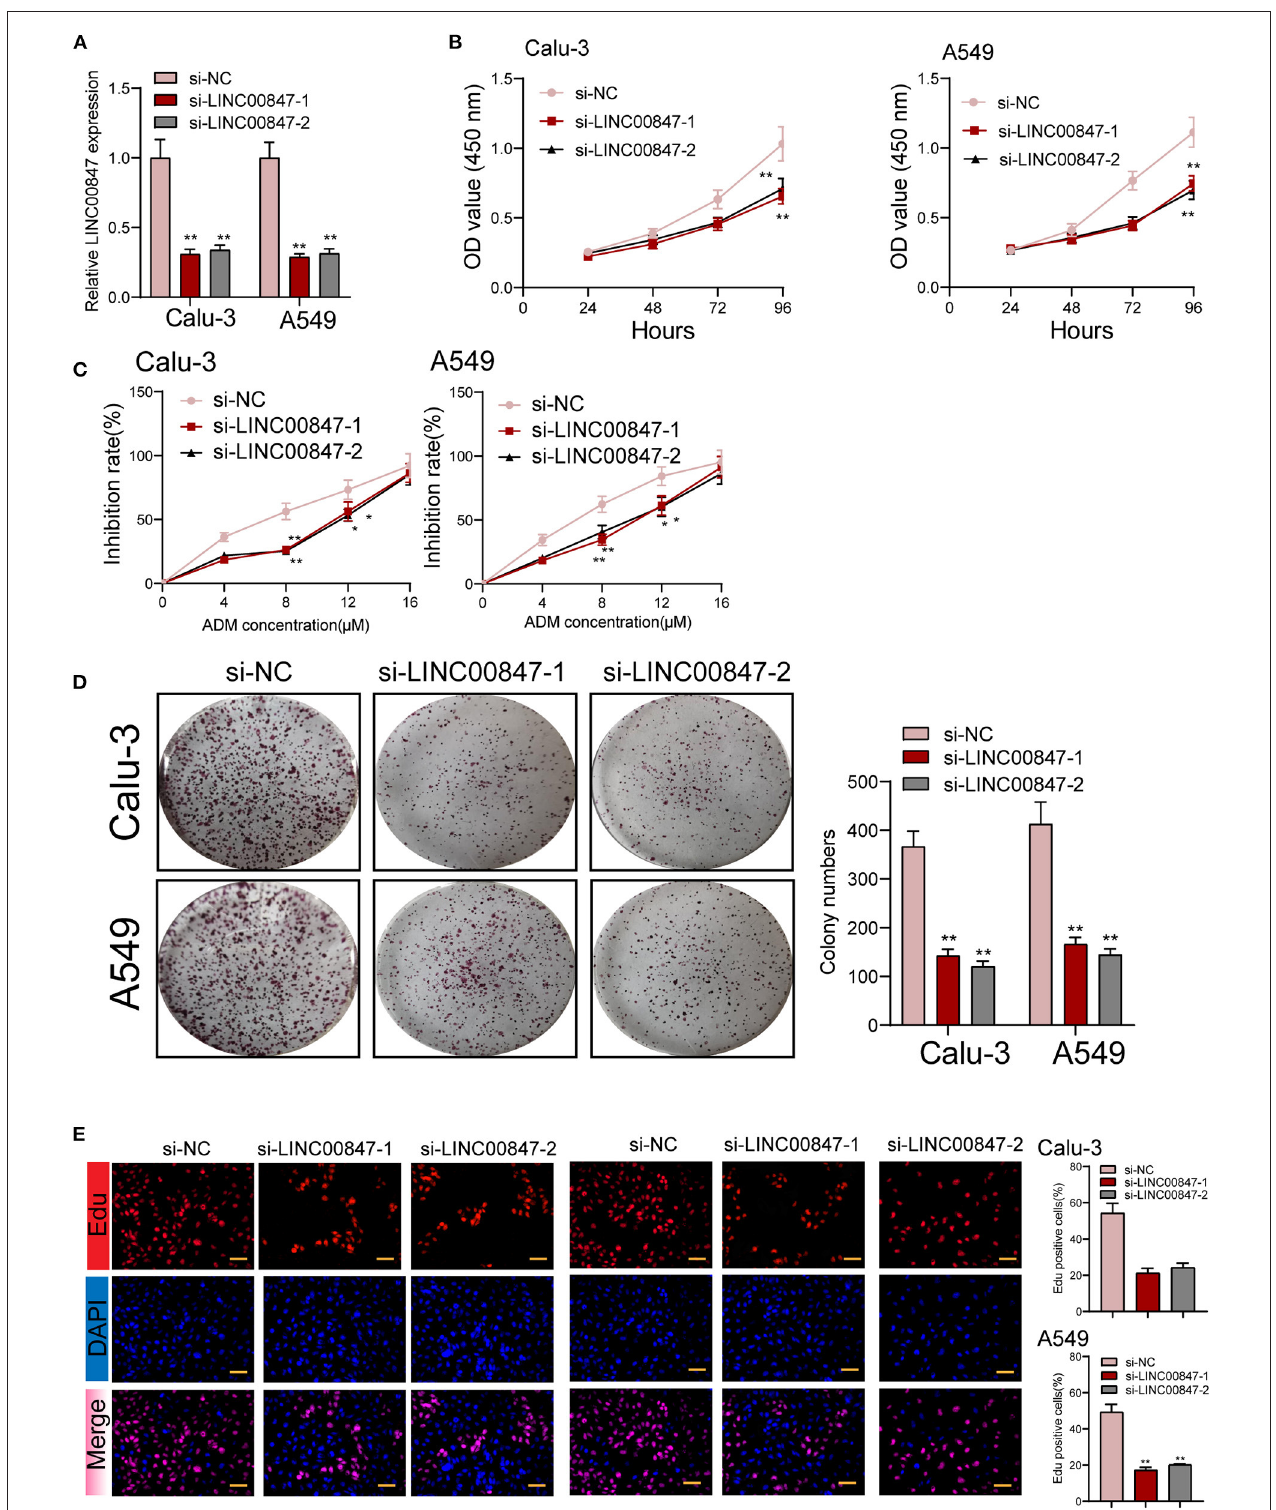
FIGURE 2 | The proliferation of NSCLC is promoted by LINC00847. (A) Relative expression of LINC00847 in NSCLC cells transfected with LINC00847 siRNA (si-LINC00847-1 or si-LINC00847-2) and scrambled siRNA. (B) CCK8 assay was used to detect cell viability. (C) Calu-3 and A549 cells were treated with ADM (0, 4,8,12,16 µ M) for 48h. Inhibition rate increased with the increase of concentration of ADM. (D) LINC00847 knockdown remarkably impaired the ability of colony formation. (E) EDU assays for the determination of the cell proliferation changes after LINC00847 down-regulation in Calu-3 and A549 cells. * p < 0.05, ** p < 0.01.